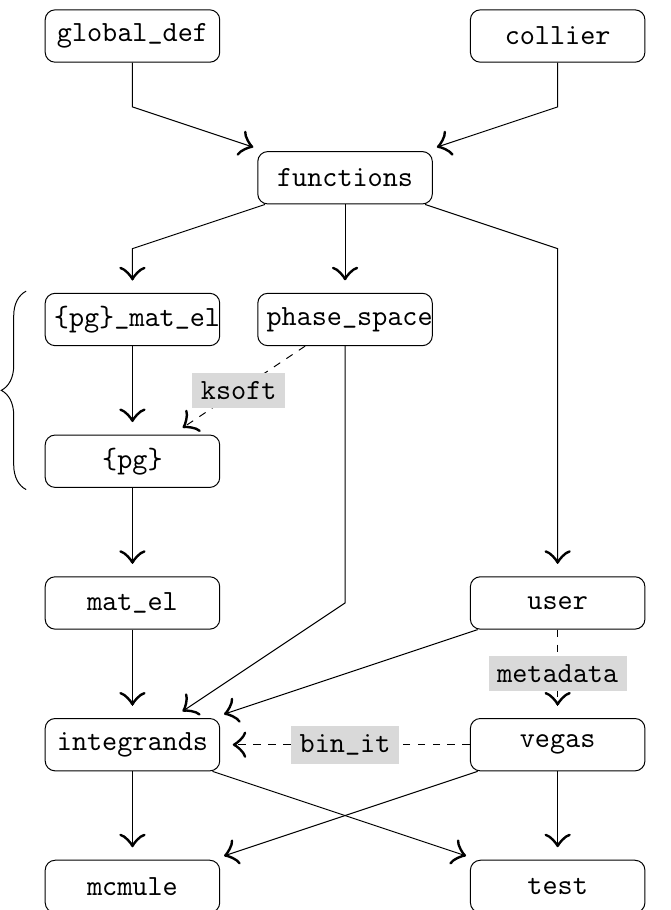
Figure 1: The structure of